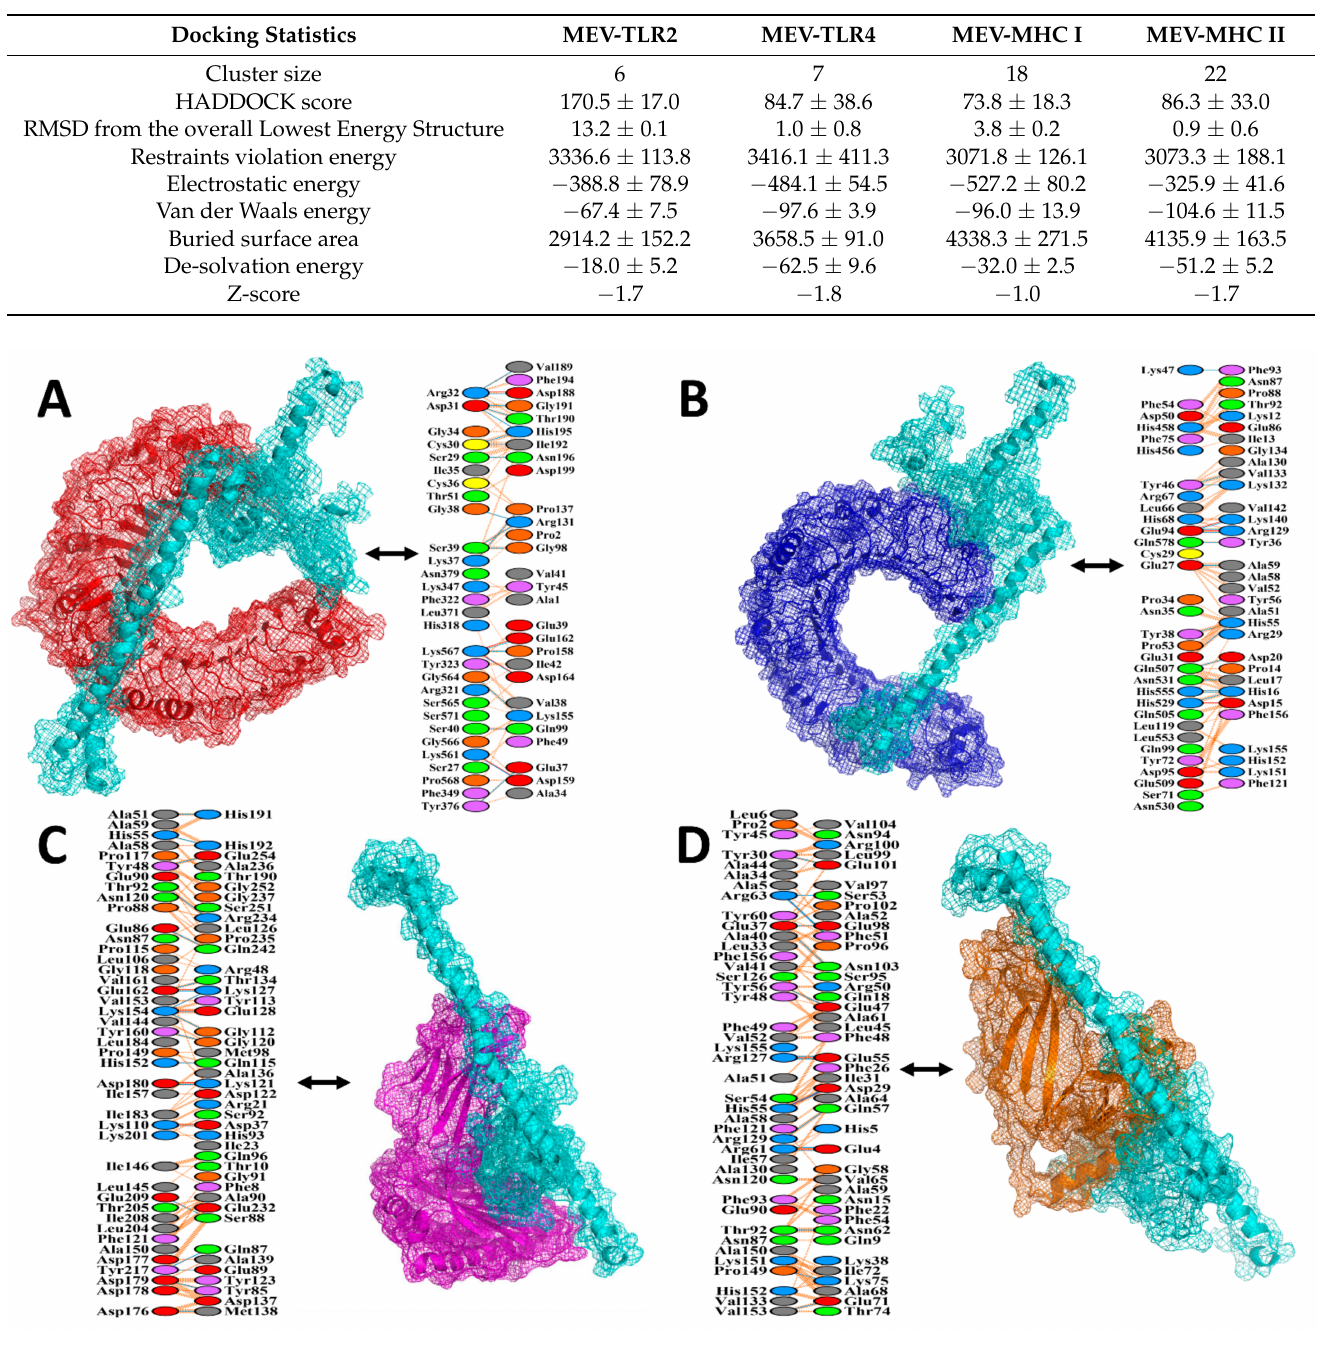
Table 5. Docking parameters of the MEV with immune receptors and MHC molecules.